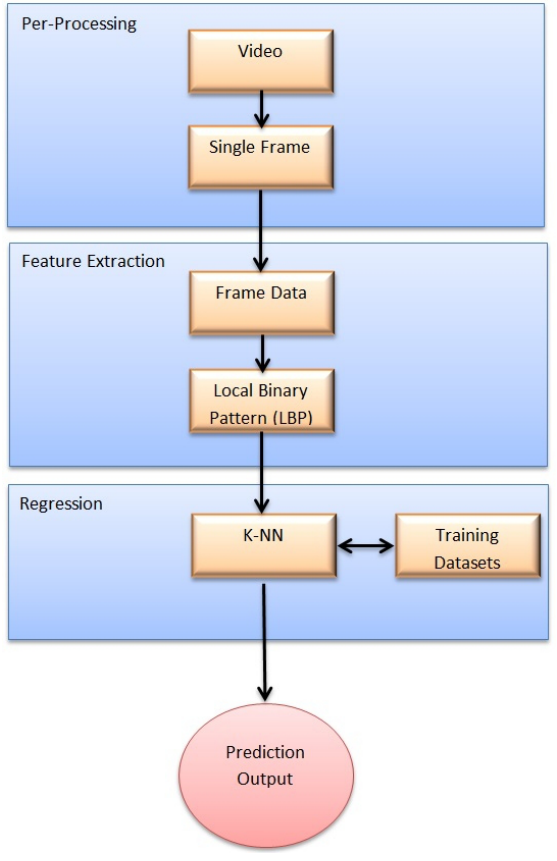
Figure 4. A high-level overview of the classifier